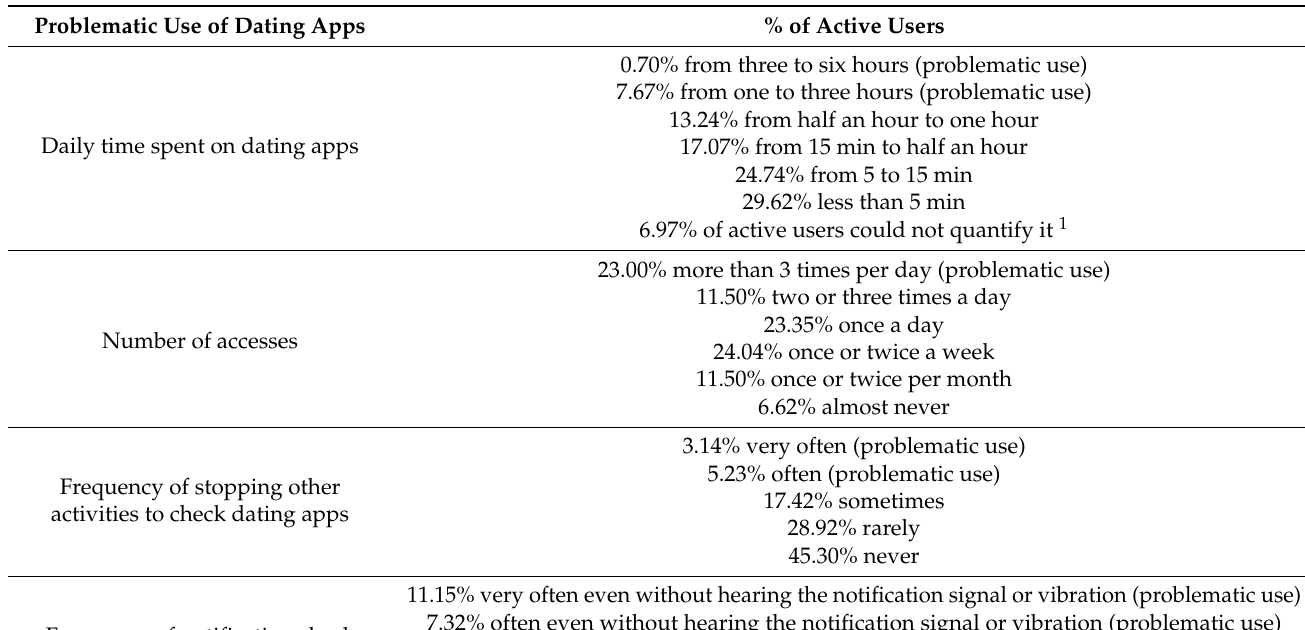
Table 4. Distribution of responses to questions that investigated the problematic use of dating apps among active users. Percentages were rounded up from